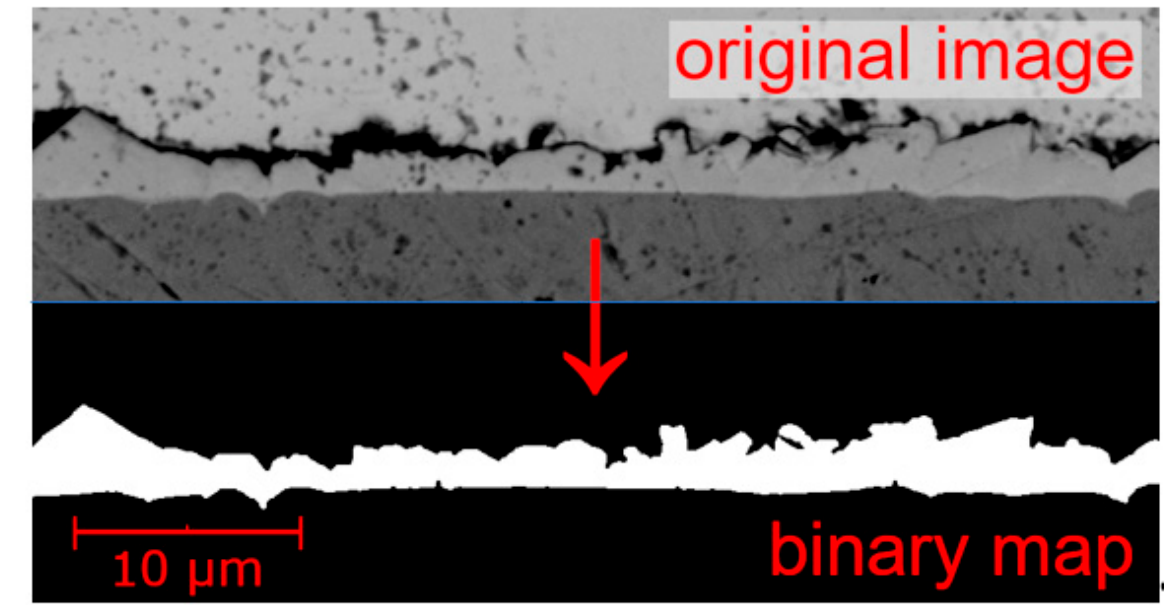
Figure 4. Conversion of the original IML SEM image to a binary map.